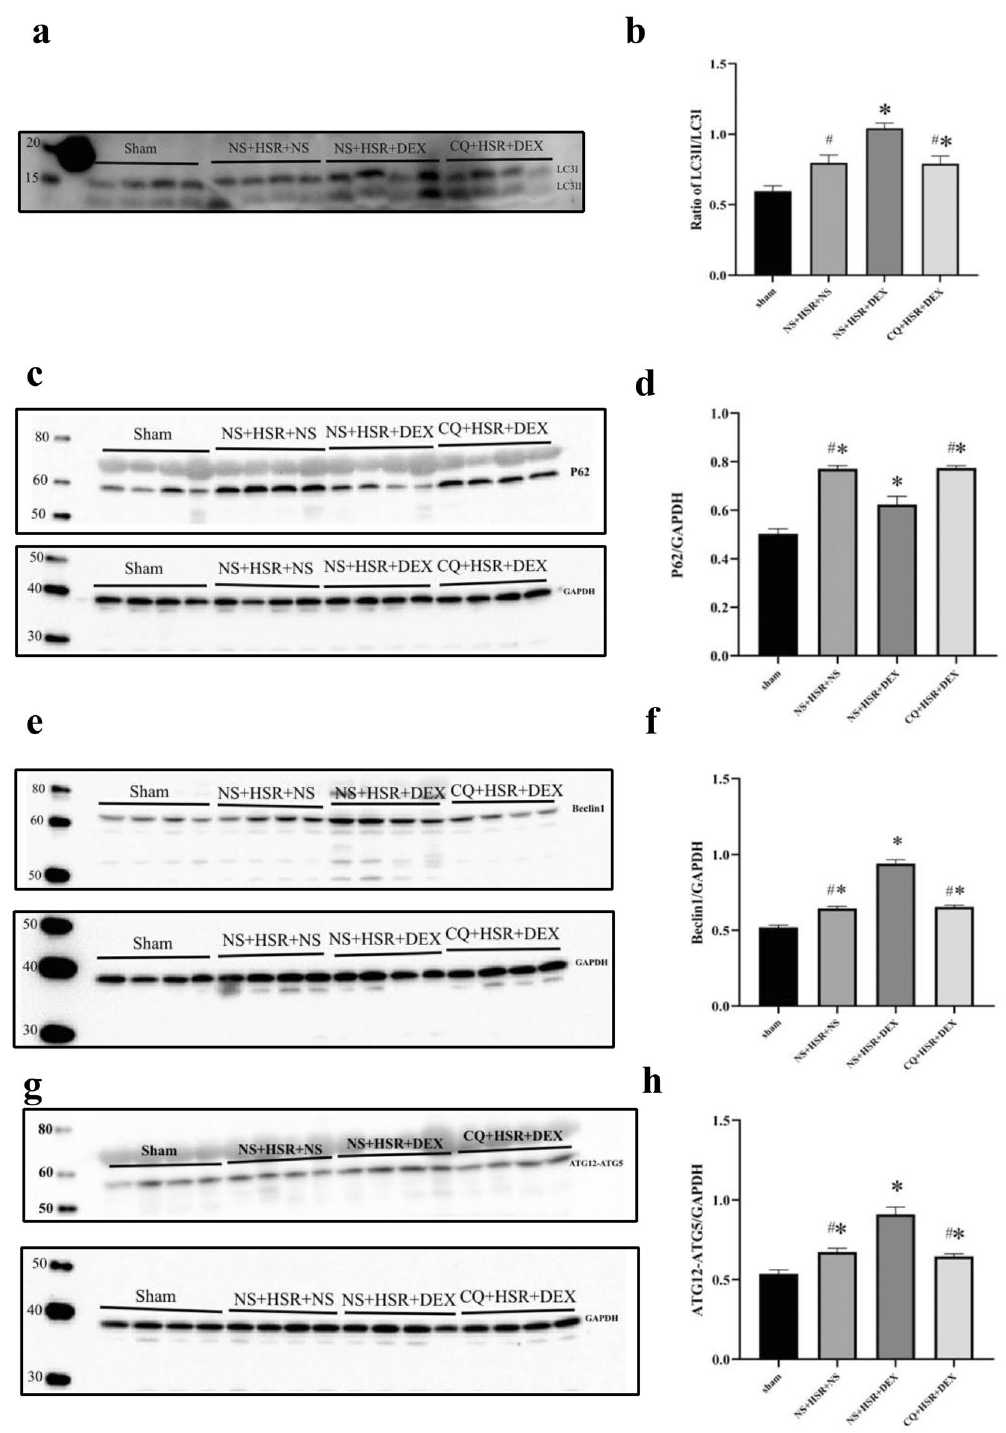
Figure 4. Effect of dexmedetomidine (DEX) injection on autophagy marker proteins in the lungs following hemorrhagic shock resuscitation (HSR). The right lung tissue of HSR rats was resected 24 h after resuscitation, protein extraction was performed, and the LC3, P62, Beclin-1, and ATG12-ATG5 expression levels were measured via western blotting. ( a , c , e , g ) Representative LC3, P62, Beclin-1, and ATG12-ATG5 immune responses in the four rat lung tissue groups with different treatment blots. GAPDH served as a loading control. ( b , d , f , h ) In western blot analysis, the LC3II grayscale measurement was normalized to the expression level of LC3I, and GAPDH expression level was used as the grayscale measurement standard for P62, Beclin-1, and ATG12-ATG5. Protein expression levels were quantified using Image Lab Version 5.0. Data are presented as mean ± standard error (n = 12 per group). Statistical analysis was performed using ANOVA, followed by the Tukey–Kramer multiple-comparison test between groups. * p < 0.05 (vs. sham) # p < 0.05 (vs. NS + HSR +